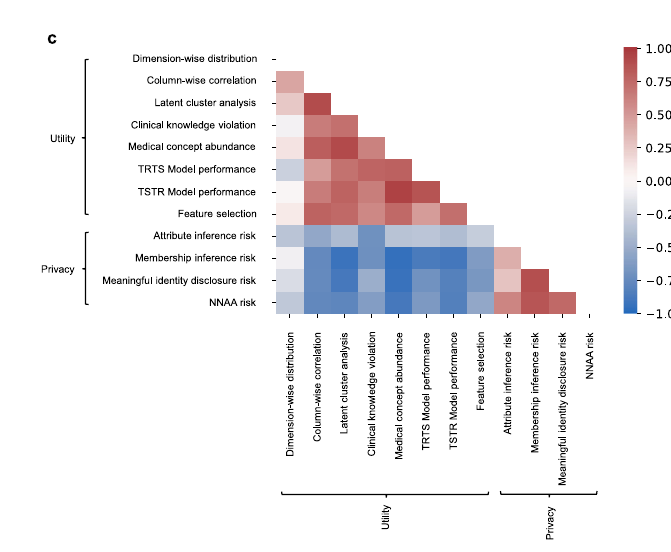
Fig. 5 | Rank-derived scores of synthesis models and metric correlations. a Rank-derived scores on synthetic data generated using UW data. b Rank-derived scores on synthetic data generated using VUMC data. c A heatmap of the Pearson